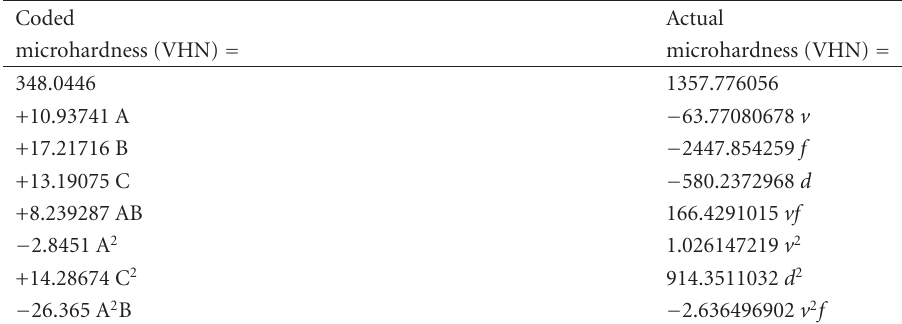
Table 6 . 4 . Final equation for microhardness in terms of coded and actual